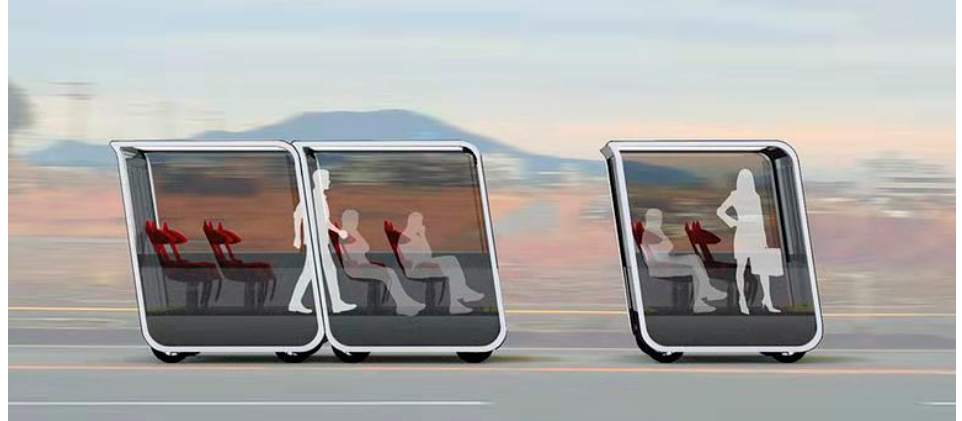
Figure 3. Passengers transfer seamlessly between coupled EMVs (source: https://www.next-future- mobility.com, accessed on 5 June 2021).